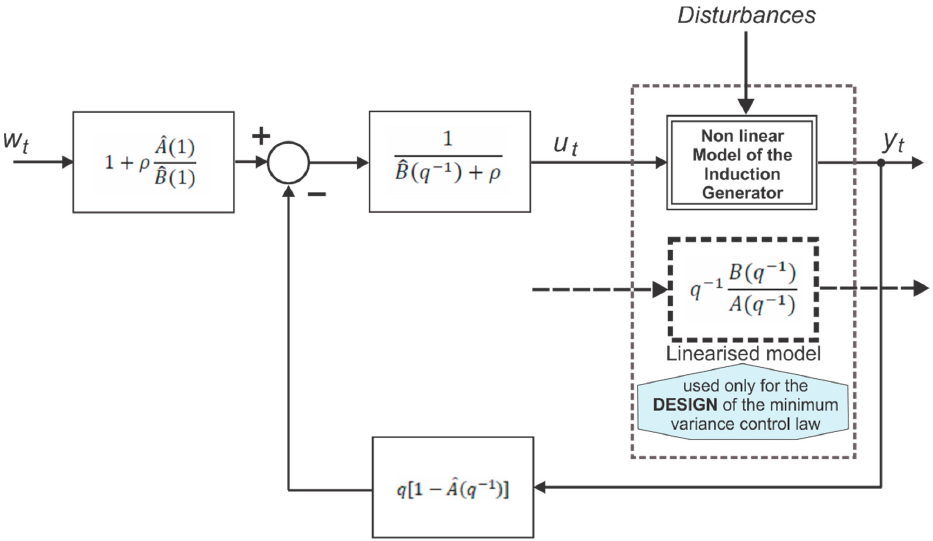
ˆ ˆ , B —polynomials of estimates). Figure 3. The minimum variance control law ( ˆ A , ˆ B —polynomials of